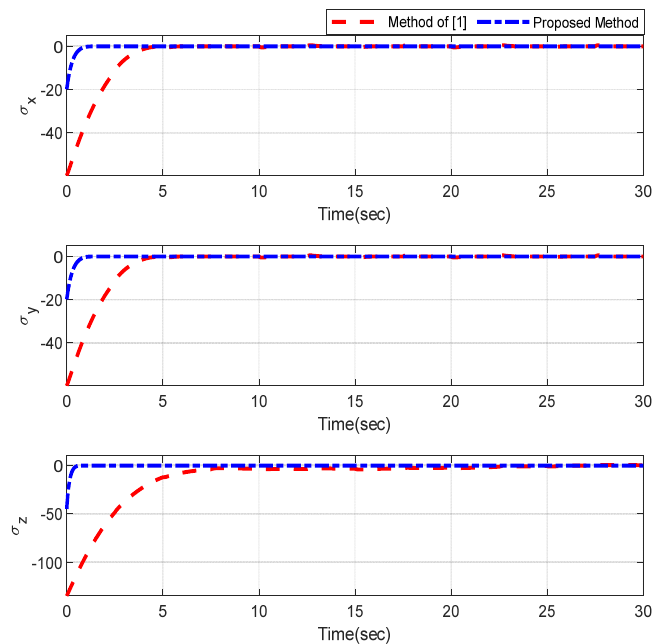
Figure 5. Trajectories of attitude tracking errors .